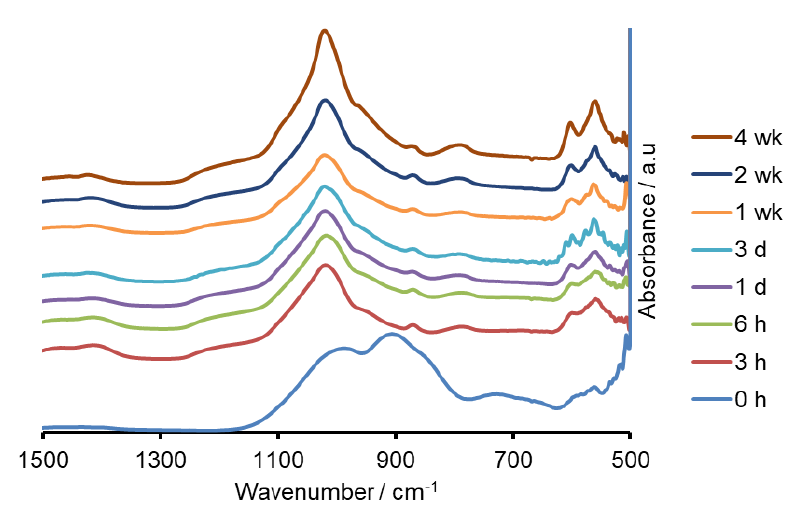
Figure 3. FTIR spectra of Na-FBAG before and after immersion.